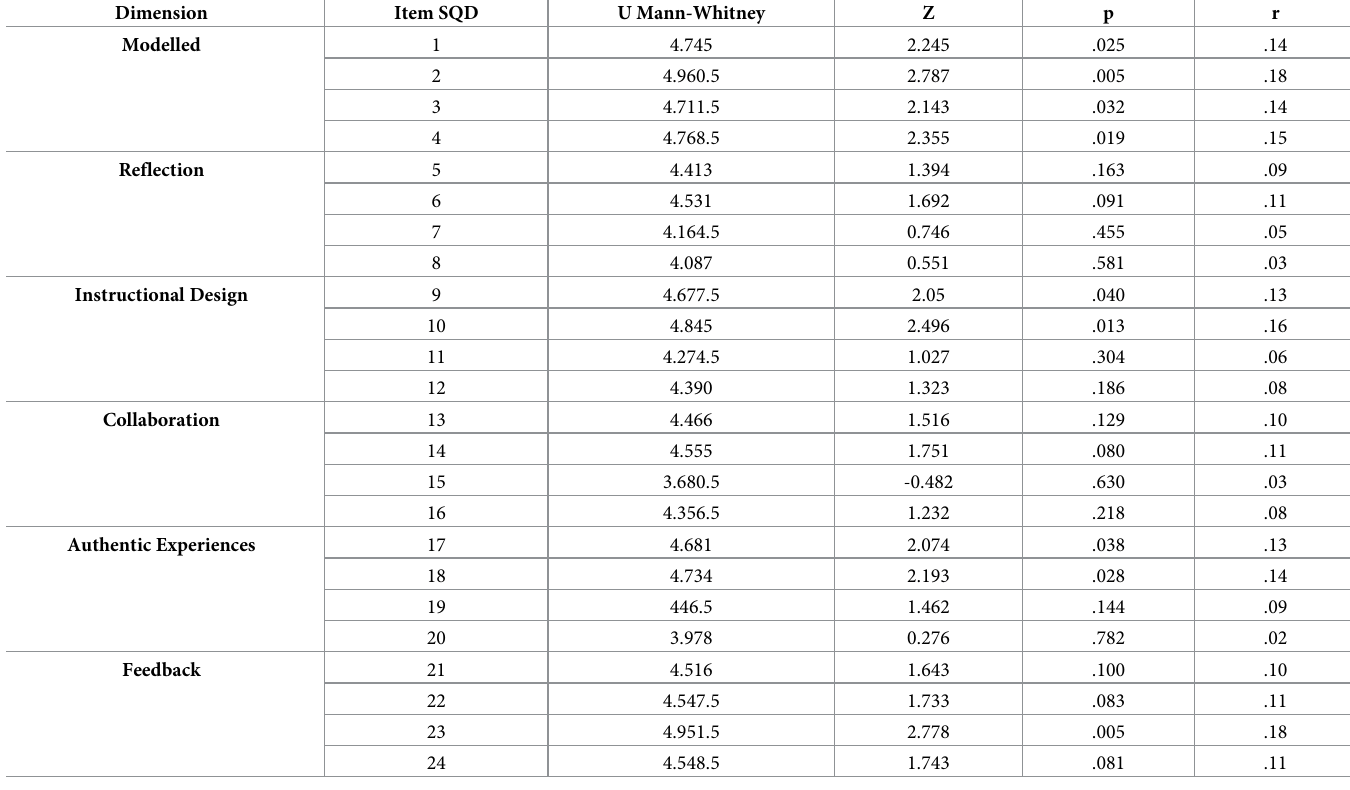
Table 5. Results of the hypothesis contrast of the variables ’ICT coordination’ with the dimensions of the SQD. Dimension Item SQD U Mann-Whitney Modelled